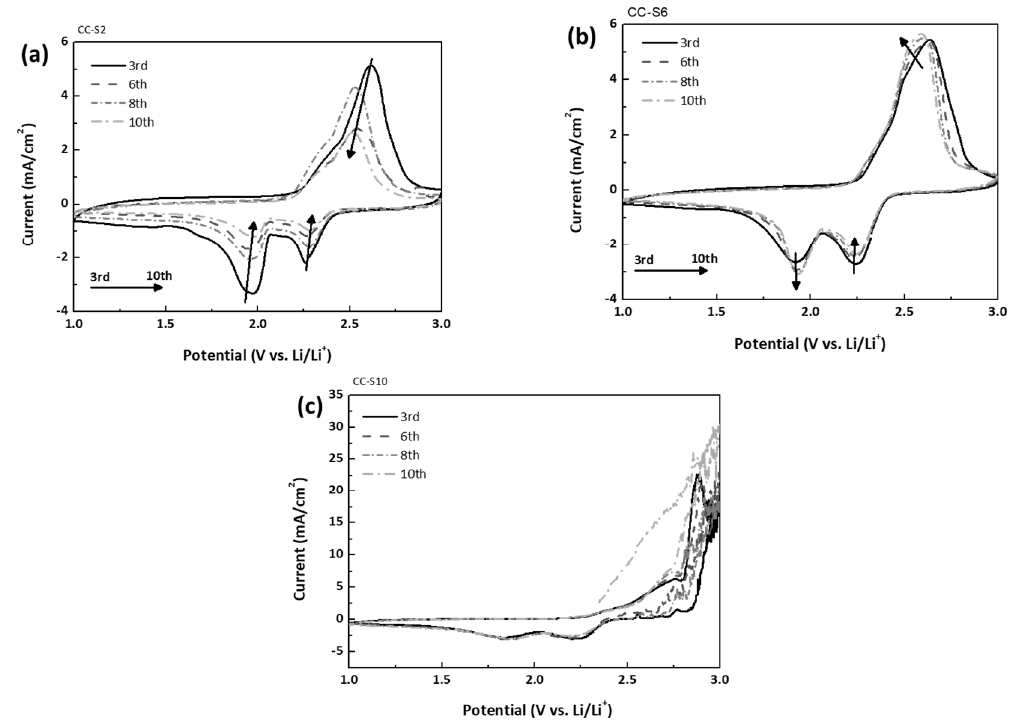
Figure 2. CV diagrams of ( a ) CC-S2; ( b ) CC-S6; and ( c ) CC-S10.